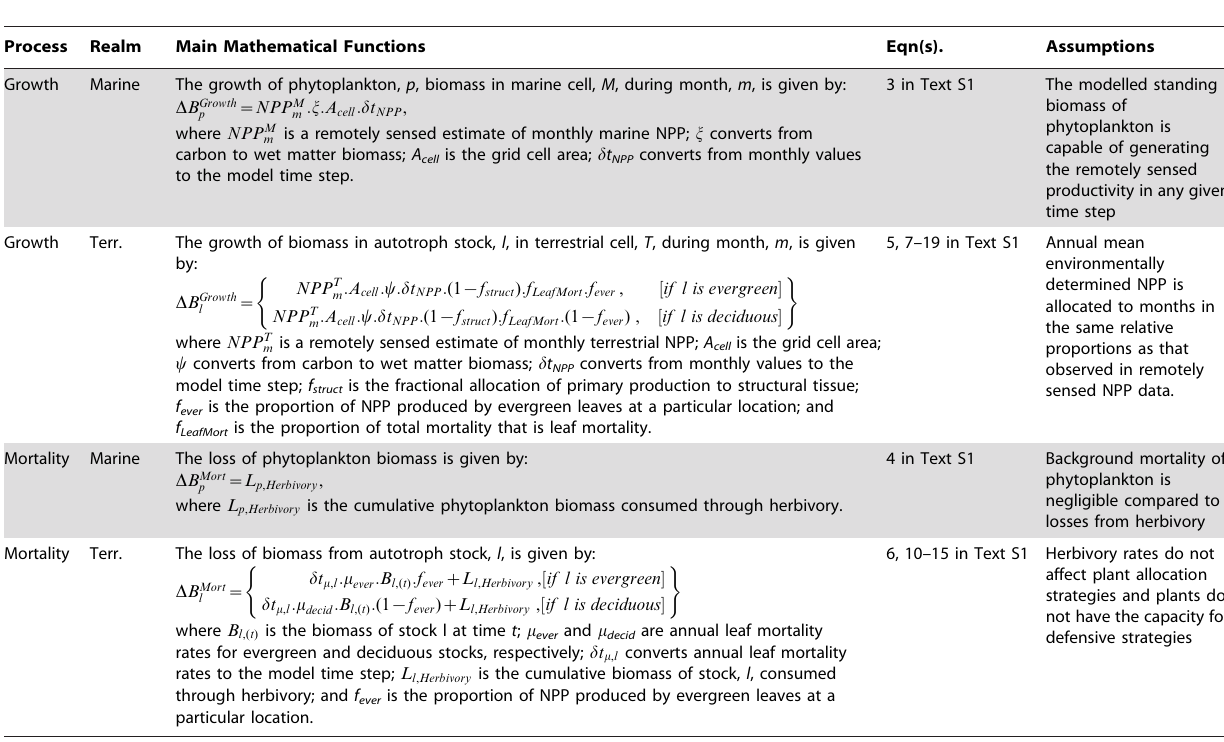
Table 5. Summary of how autotroph ecological processes are modelled (for full details, see Text S1 and Table S2).